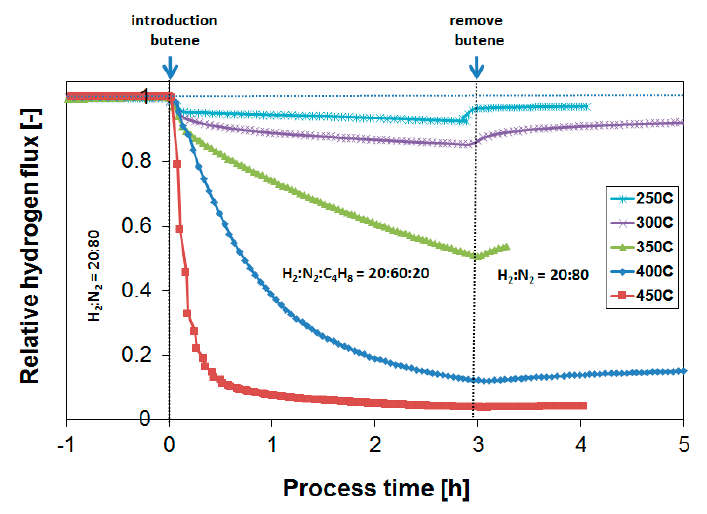
Figure 8. Effect of temperature on the obtained relative H 2 flux after butylene introduction. The H 2 /butylene ratio is equal to 1.